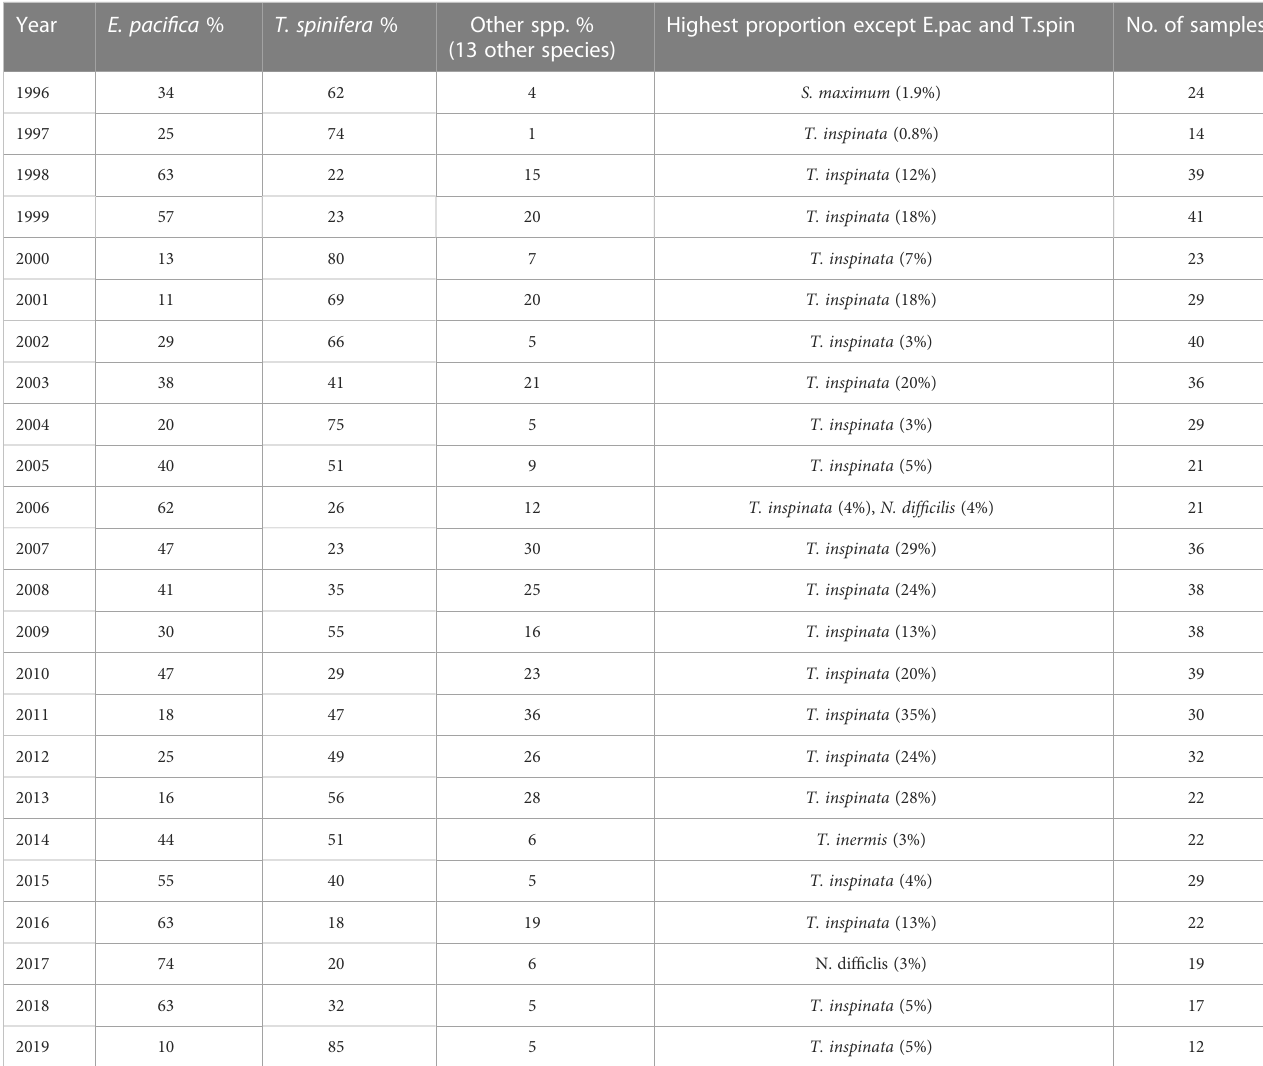
TABLE 1 Mean % contribution of E. paci fi ca , T. spinifera , and other spp. to the overall euphausiid community at sampling stations off the west coast of Vancouver Island between 1996 and 2019. Year E. paci fi ca